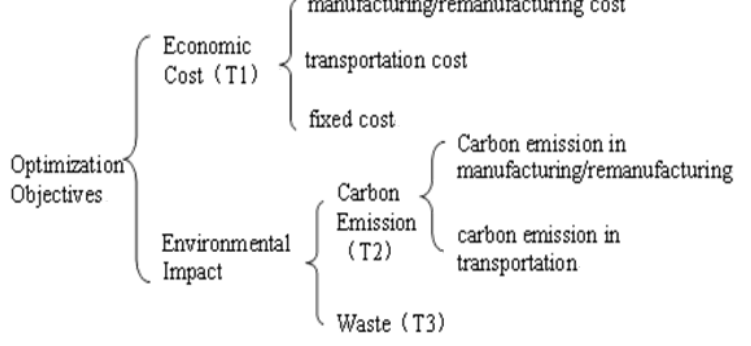
Figure 2. Optimization objectives of the